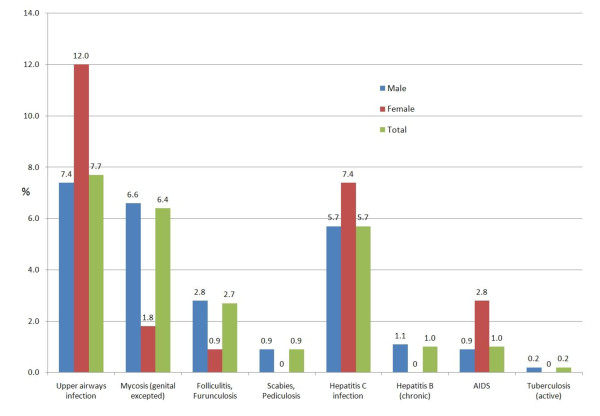
Health problems coded as infectious diseases (23.5%; 95%CI 21.7-25.3)